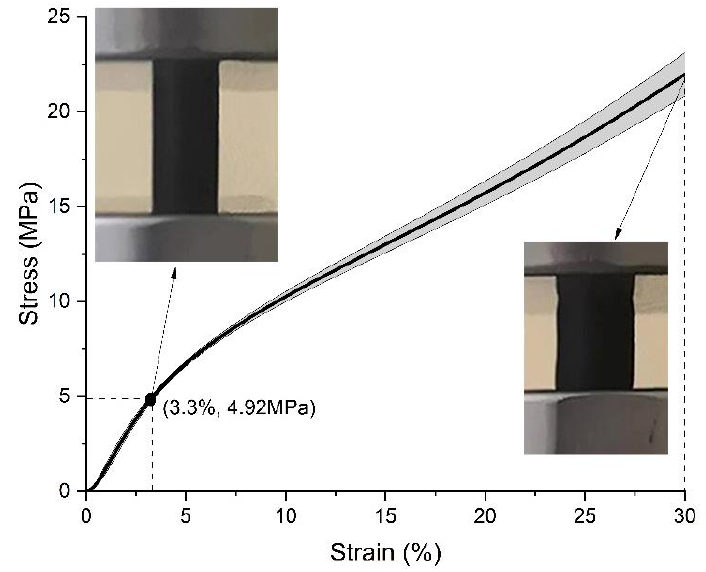
Figure 10. Compression test results of specimens printed with a solid